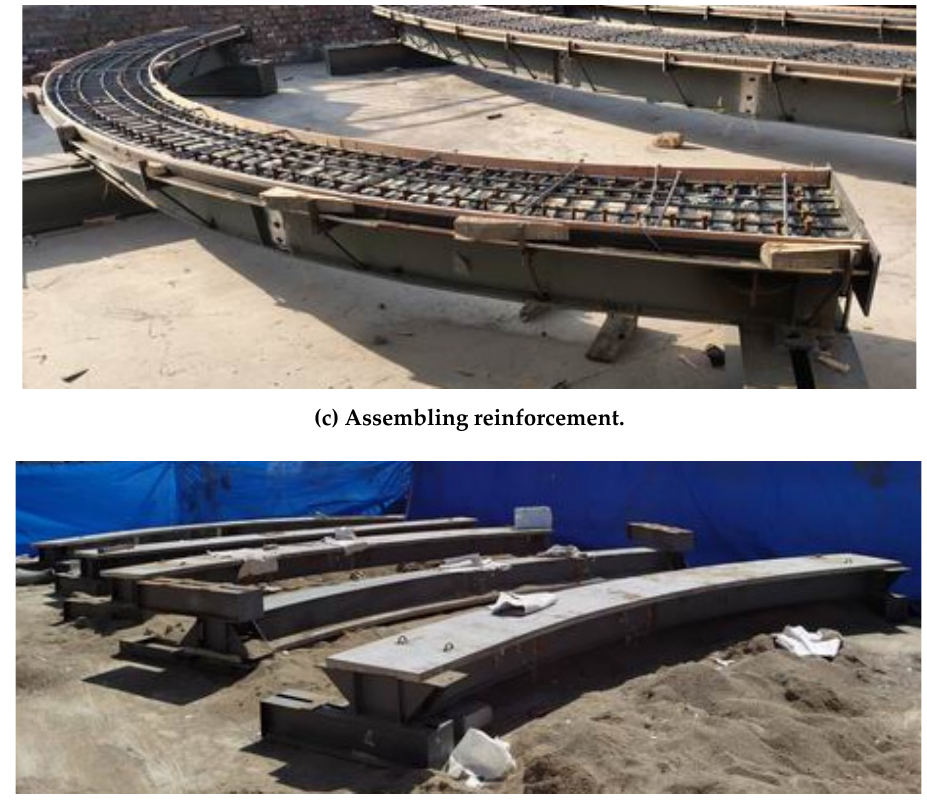
Figure 3. The manufacturing process of the test specimens.